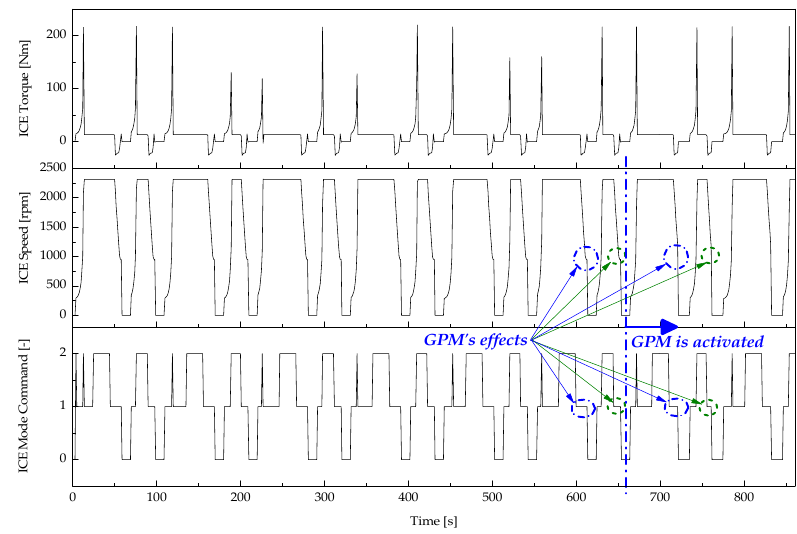
Figure 15. Simulated ICE mode command and speed response using PISSC during the first eight cycles.